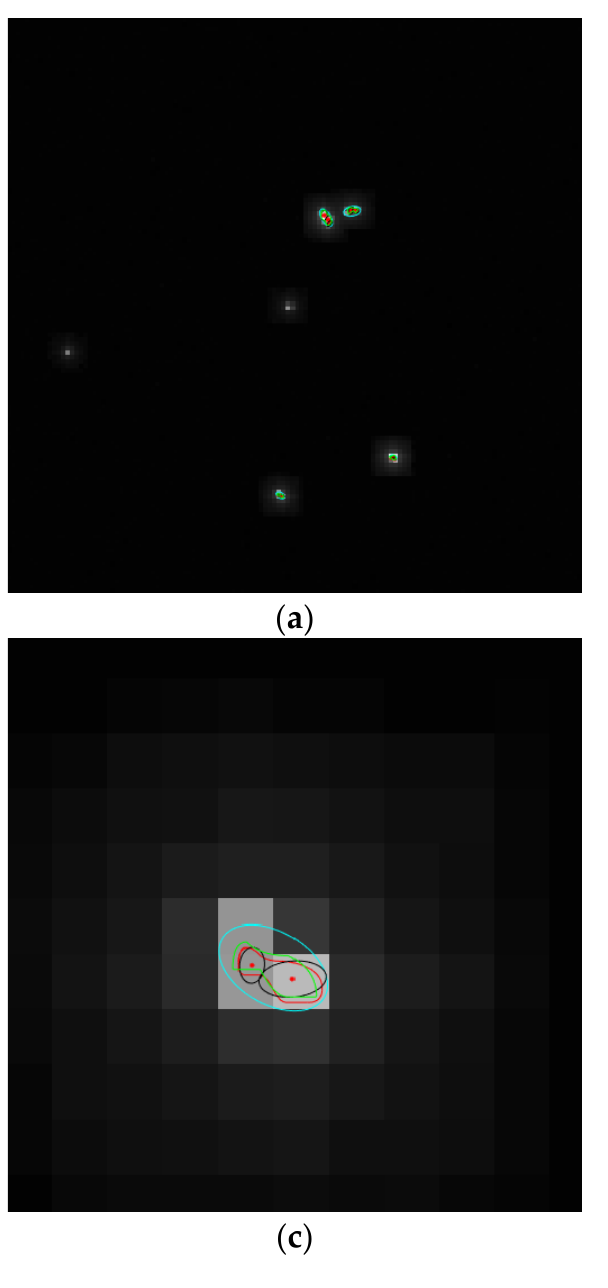
Figure 10. The extension estimation of extended targets under different algorithms for frame 90. ( a ) the estimation of extension; ( b ) enlarged image of target 1 and target 2; ( c ) enlarged image of target 3; ( d ) enlarged image of target 4.